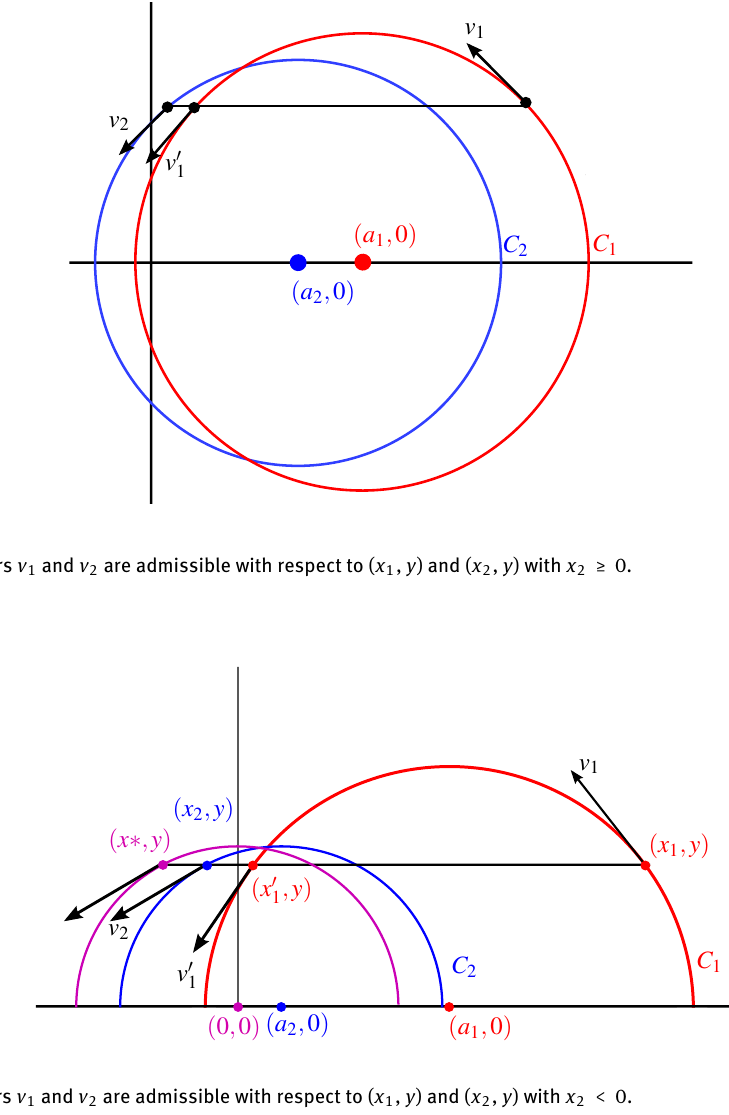
Figure 9: The vectors v 1 and v 2 are admissible with respect to ( x 1 , y ) and ( x 2 , y ) with x 2 < 0